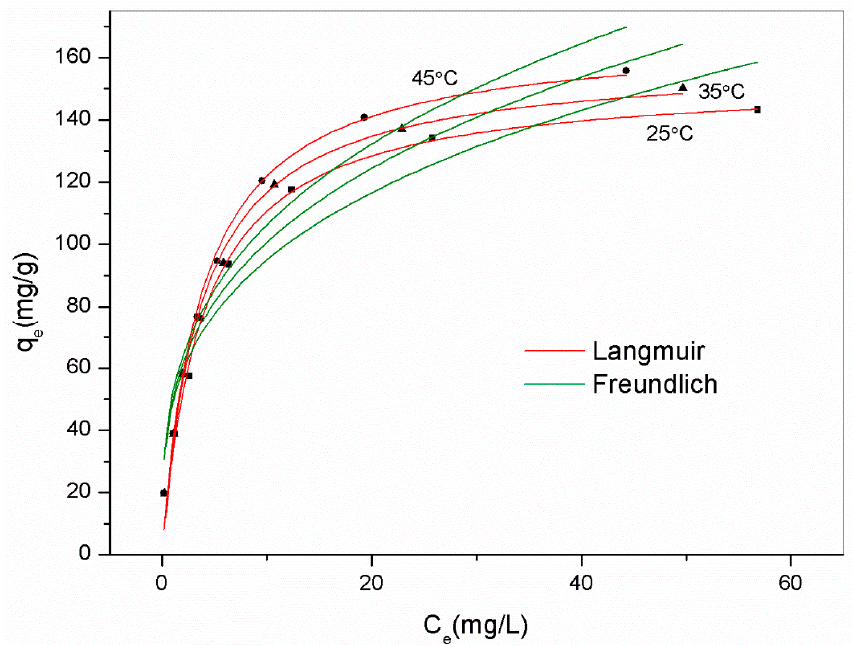
Figure 13 . Experimental data for Pb(II) removal by AM41ES-60-48 at different temperatures and fitted isotherms. Experimental condition s : adsorption temperature T = 25, 35, and 45 °C, adsorbent dose m = 50 mg, solution volume V = 50 mL, contact time t = 200 min, pH = 6, and initial Pb(II) concentration C 0 = 20, 40, 60, 80, 100, 130, 160, and 200 mg/L.